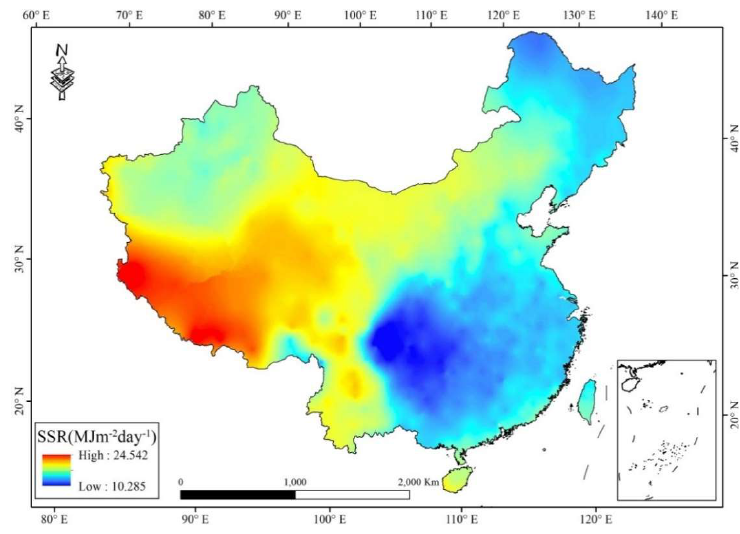
Figure 17. Distribution of the annual mean SSR values over Mainland China during 1980–2015.